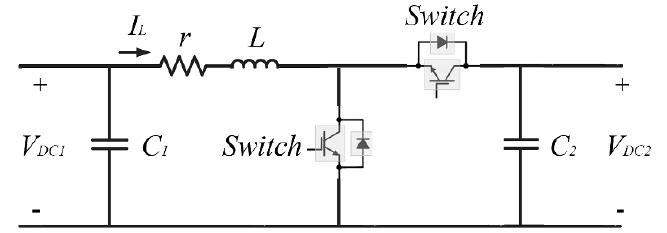
Figure 2. ( a ) Structure of an AC/DC MMC, ( b ) structure of each arm, ( c ) equivalent model of SM.